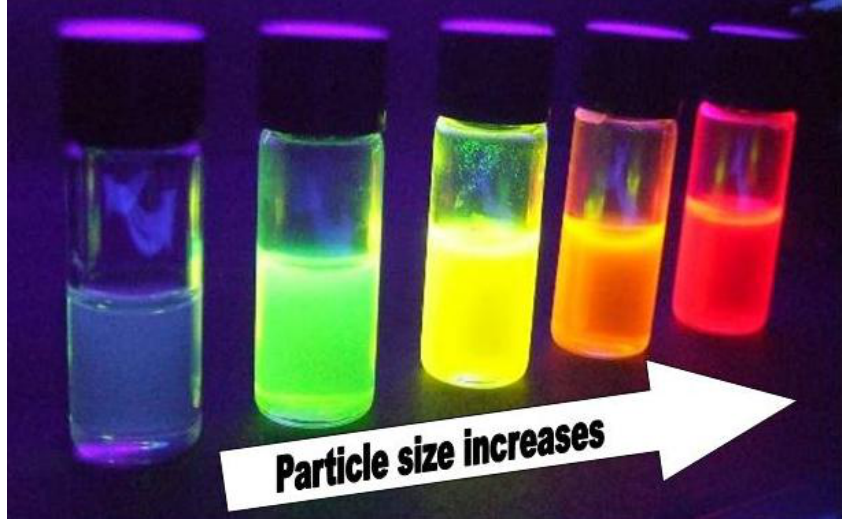
Figure 2. Photoluminescent CdSe/ZnS QDs dispersed in toluene (UV light